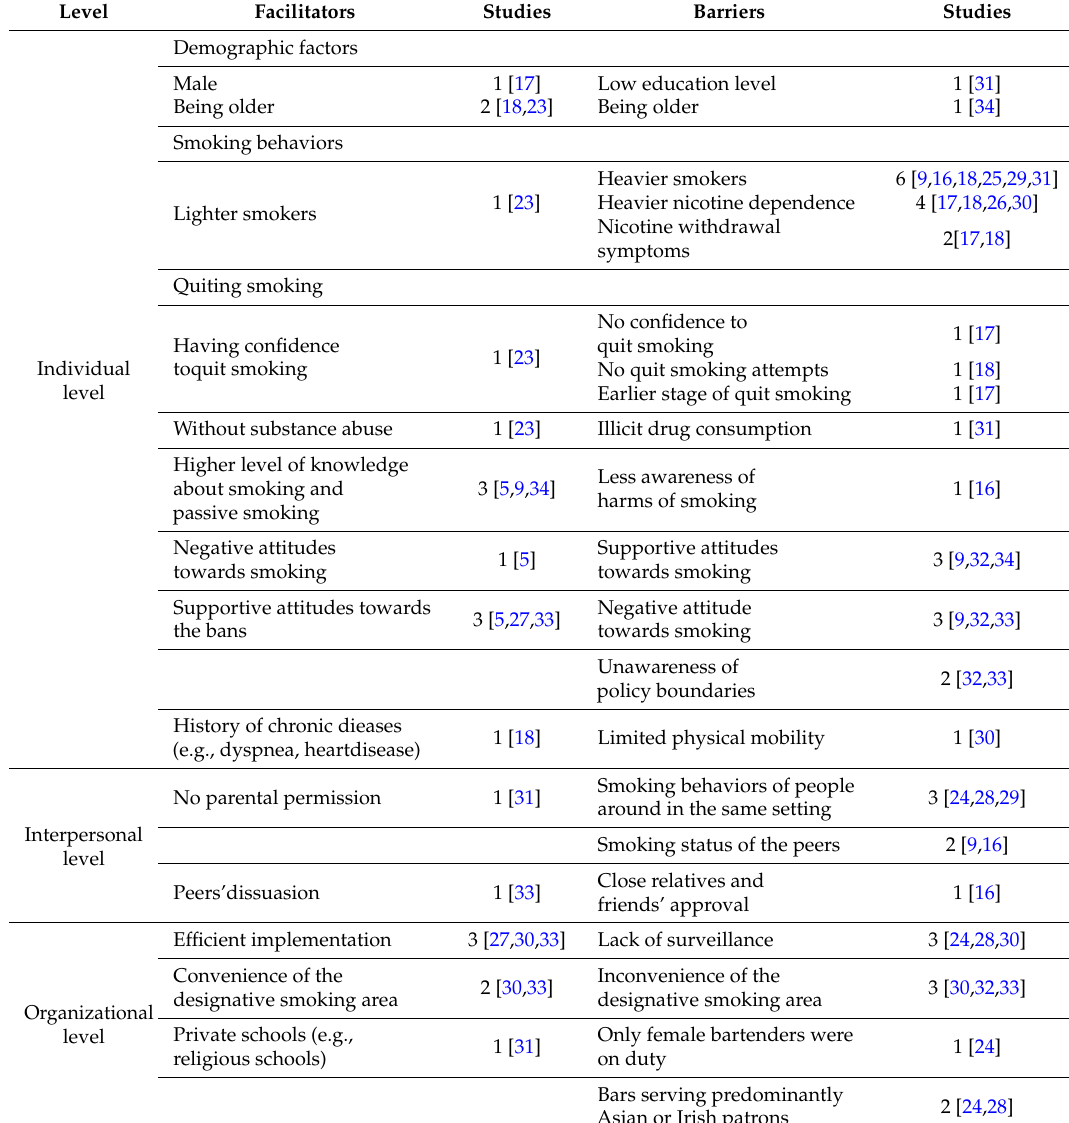
Table 2. Facilitators and barriers to smokers’ compliance with smoking bans in public